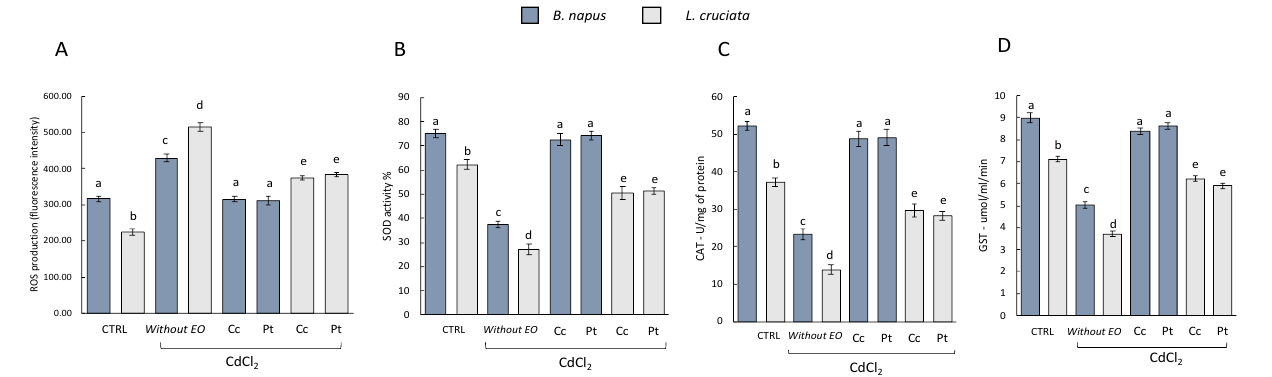
Figure 1. ( A ) ROS production and antioxidant/detoxifying enzyme activities ( B ) SOD, ( C ) CAT, and ( D ) GST in B. napus and L. cruciate in the control samples [i.e., without pretreatment with Cachrys cristata (Cc) and Prangos trifida (Pt) essential oils (EOs), and without treatment with CdCl 2 ], in samples without pretreatment with EOs and exposed to treatment with CdCl 2 , and in samples pretreated with EOs and exposed to CdCl 2 treatment. Bars not accompanied by the same letter (a–e) were significantly different at p < 0.05. Data are mean of three independent experiments ± SE ( n = 5).